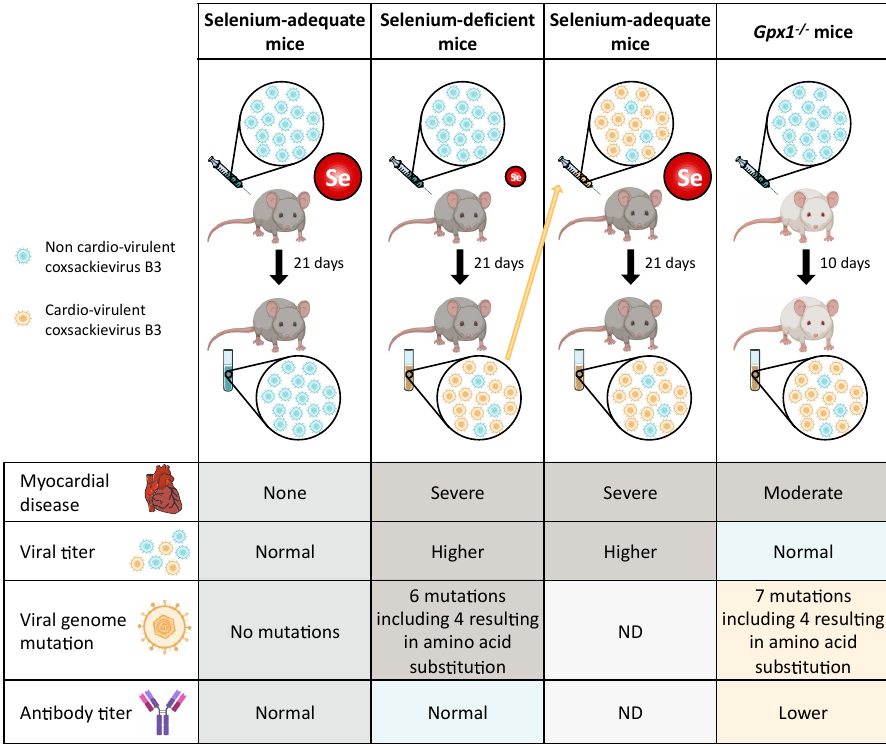
Figure 3. Evolution of the pathogenicity of Coxsackie virus as a function of selenium intake or